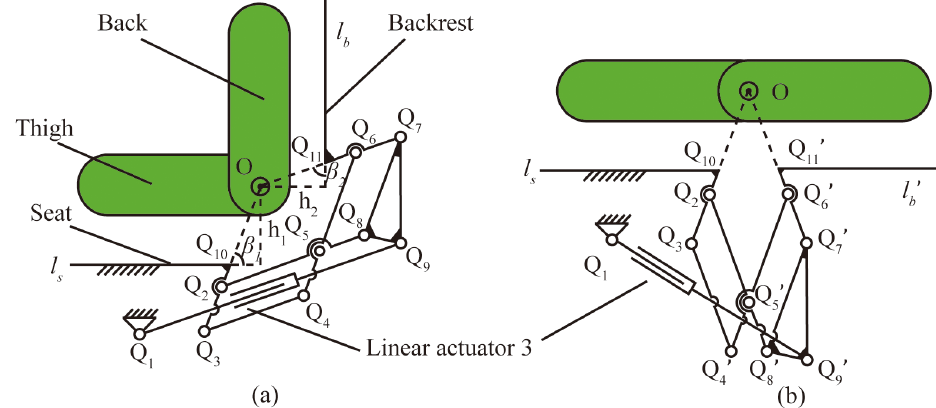
Figure 4. Schematic diagram of the back module. (a) Schematic diagram of the back module at the sitting posture. (b) Schematic diagram of the back module at the lying